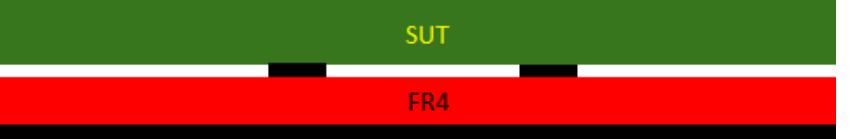
Figure 6. The cross-section of a simplified MRR configuration—without the “cover” layer on top of an